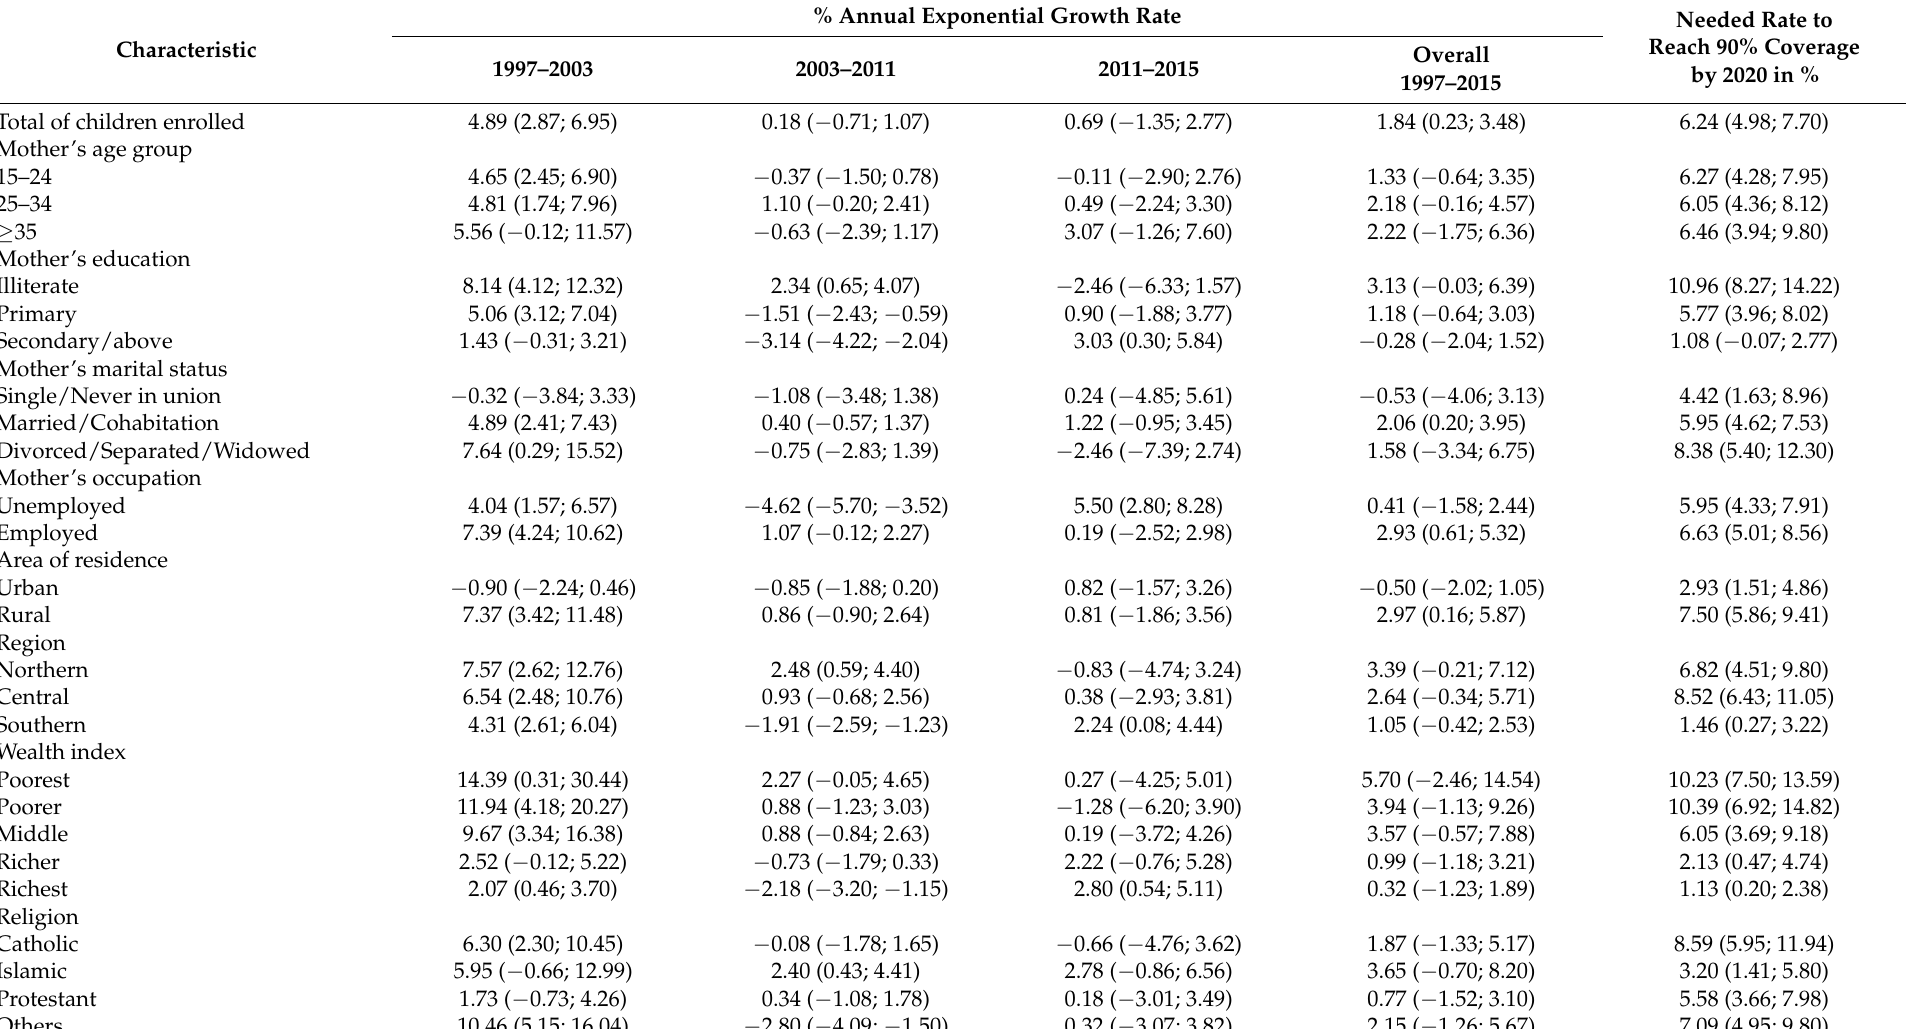
Table 3. Yearly growth rate of full immunization coverage (FIC) and needed rate to reach 90% FIC.